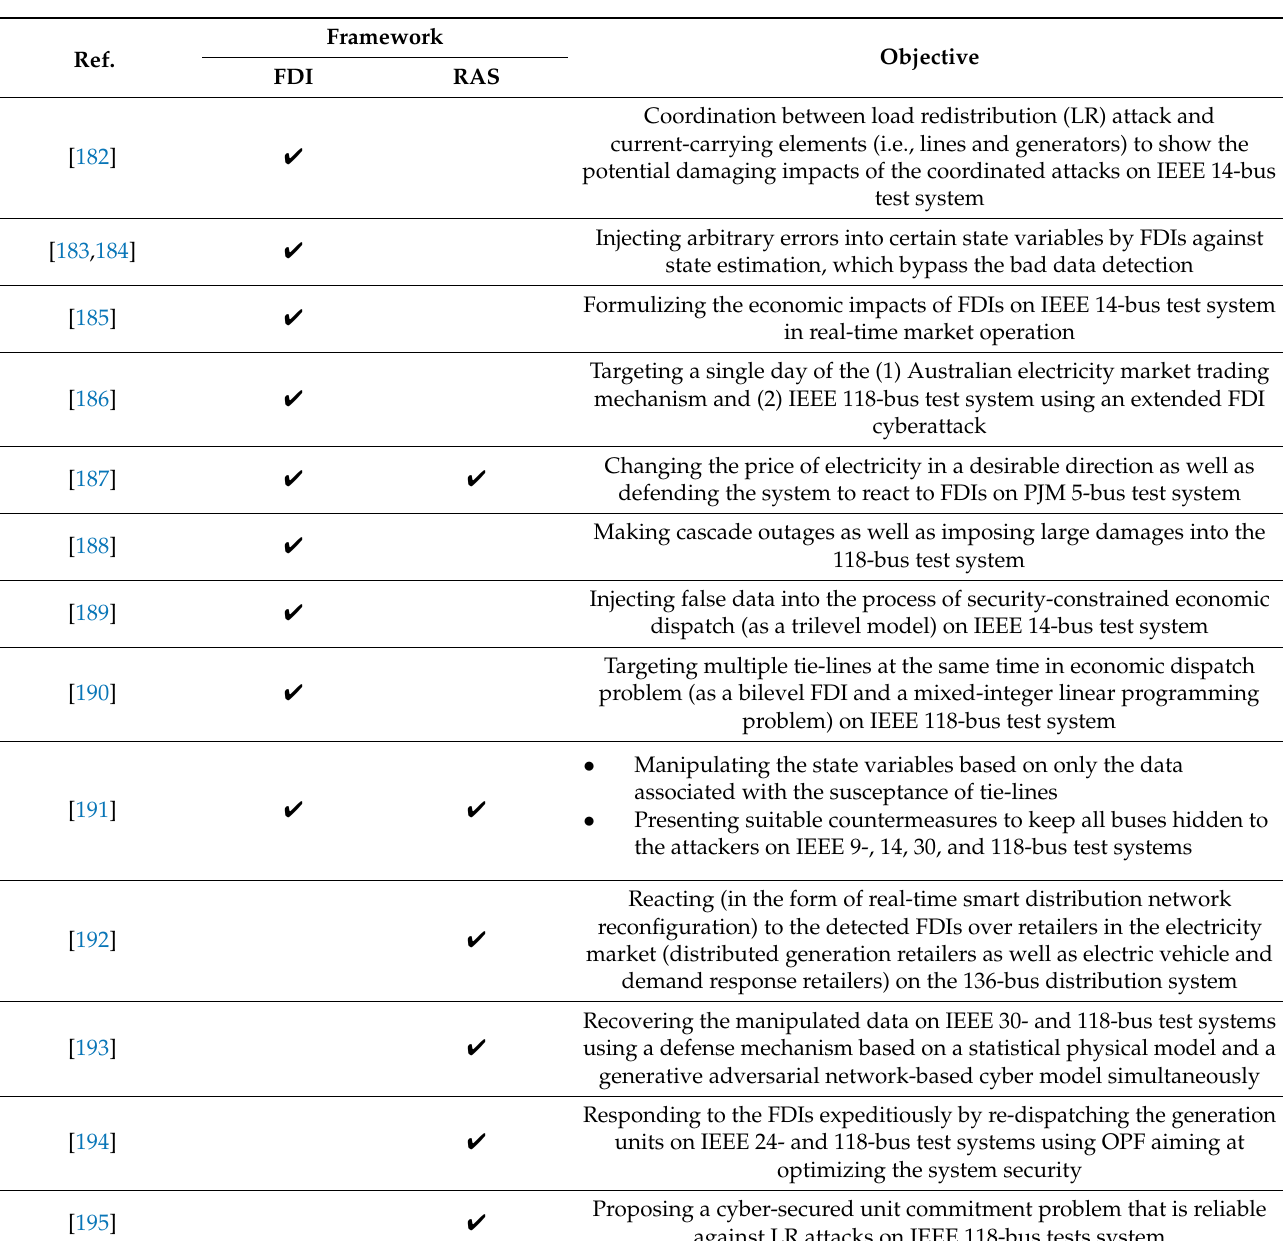
Table 8. Overview of the recent publications in the field of cybersecurity.